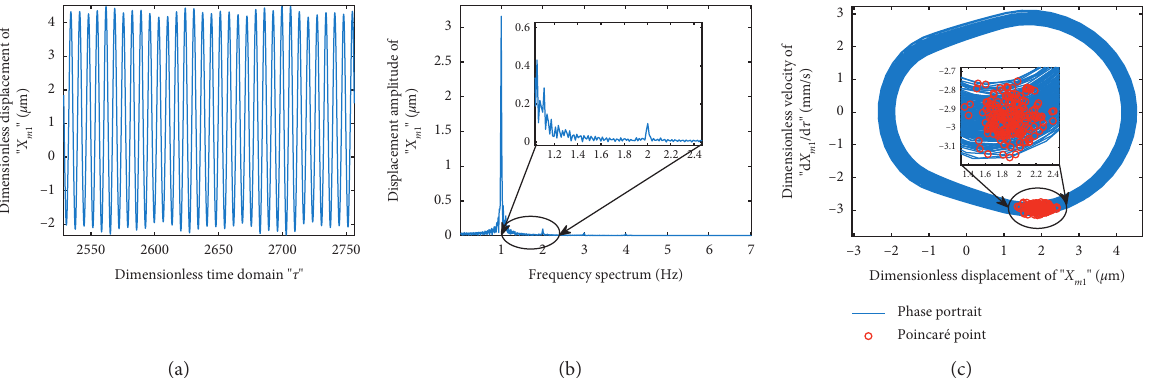
Figure 7: The dynamic response of system X m 1 at 19522rpm. (a) Time-domain response. (b) FFTspectrum. (c) Phase plane and Poincar´e point.